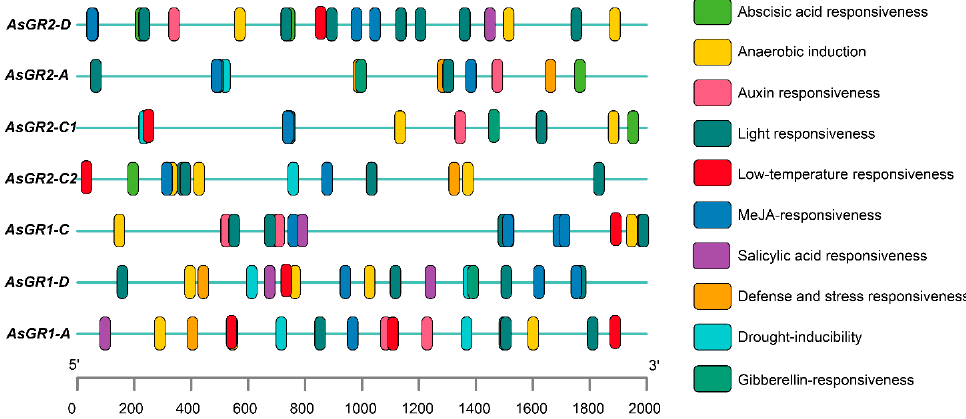
Figure 6. Cis -regulatory elements in the promoters of AsGR gene family.